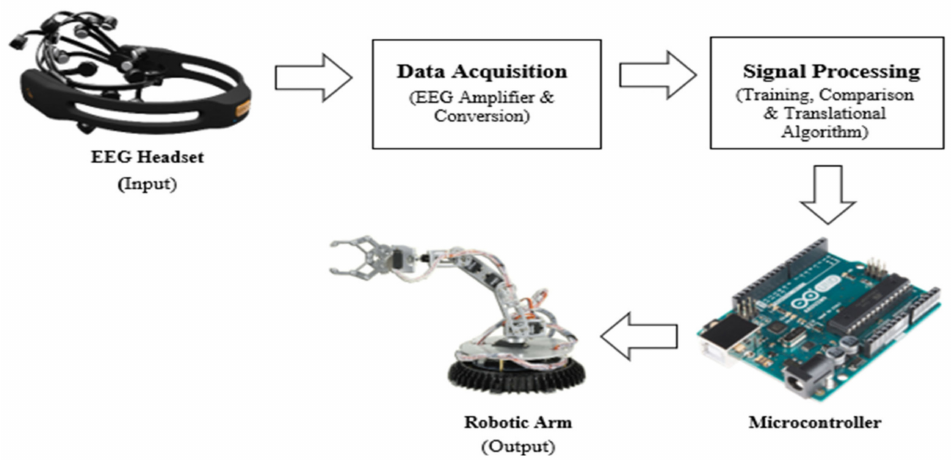
Figure 1. Block Diagram and System